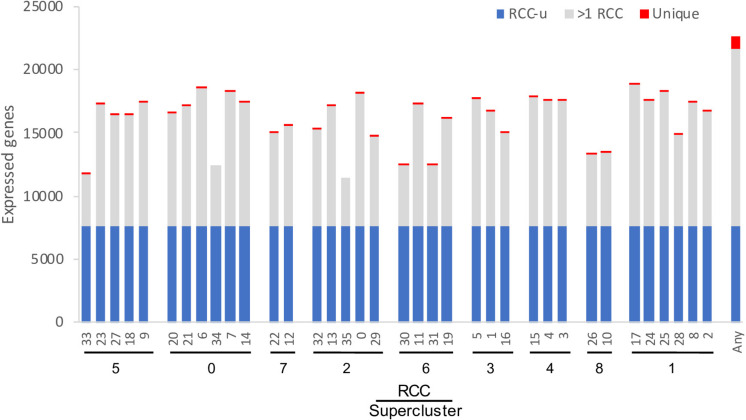
Number of genes expressed per cluster. The 36 RCCs are grouped by Ryu et al. (2019) supercluster (roughly representing cell types and developmental states; Figure 1), and ordered roughly from the interior (stele) to the exterior (epidermis) and tip (root cap) of the root. RCC-ubiquitous (RCC-u) is the subset of genes expressed in all 36 RCCs, “>1 RCC” is the subset expressed in 2–35 RCCs, and “Unique” is the subset expressed in only one RCC. “Any” is the union of all genes expressed in at least one of the 36 clusters.